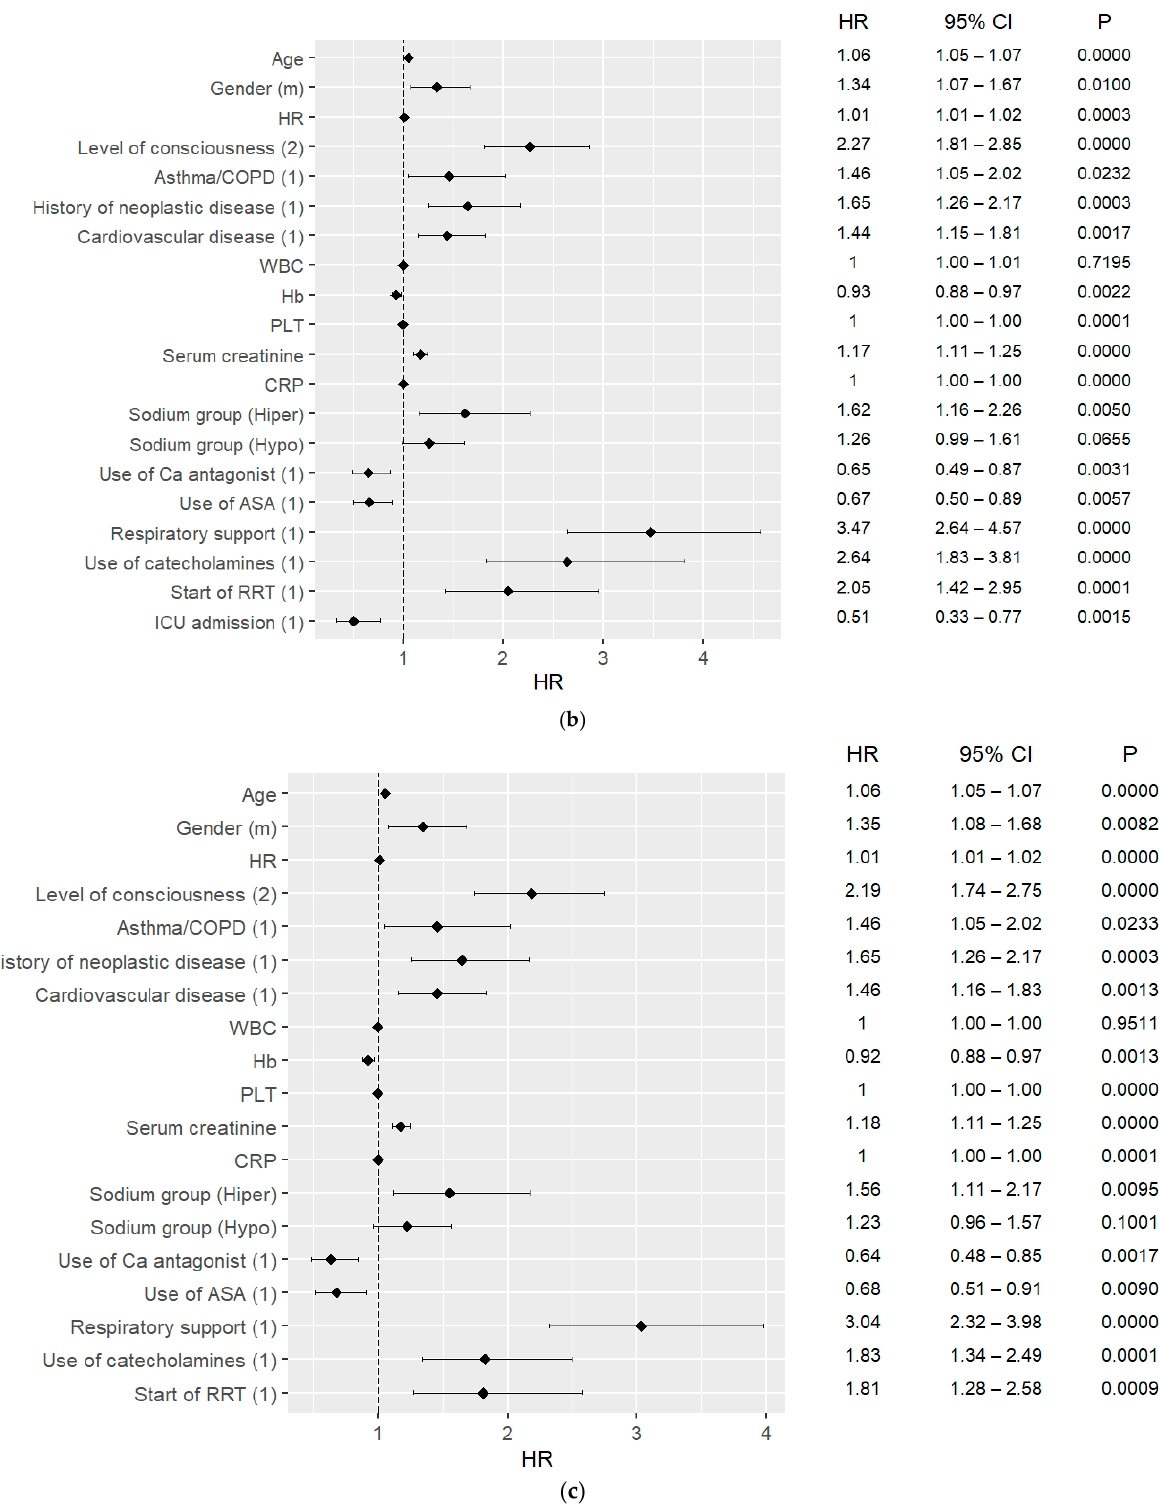
Figure 3. ( a ) 90-day mortality predictors in COVID patients, data on admission; ( b ) 90-day mortality predictors in COVID patients, including ICU patients; ( c ) 90-day mortality predictors in COVID patients, excluding ICU patients.